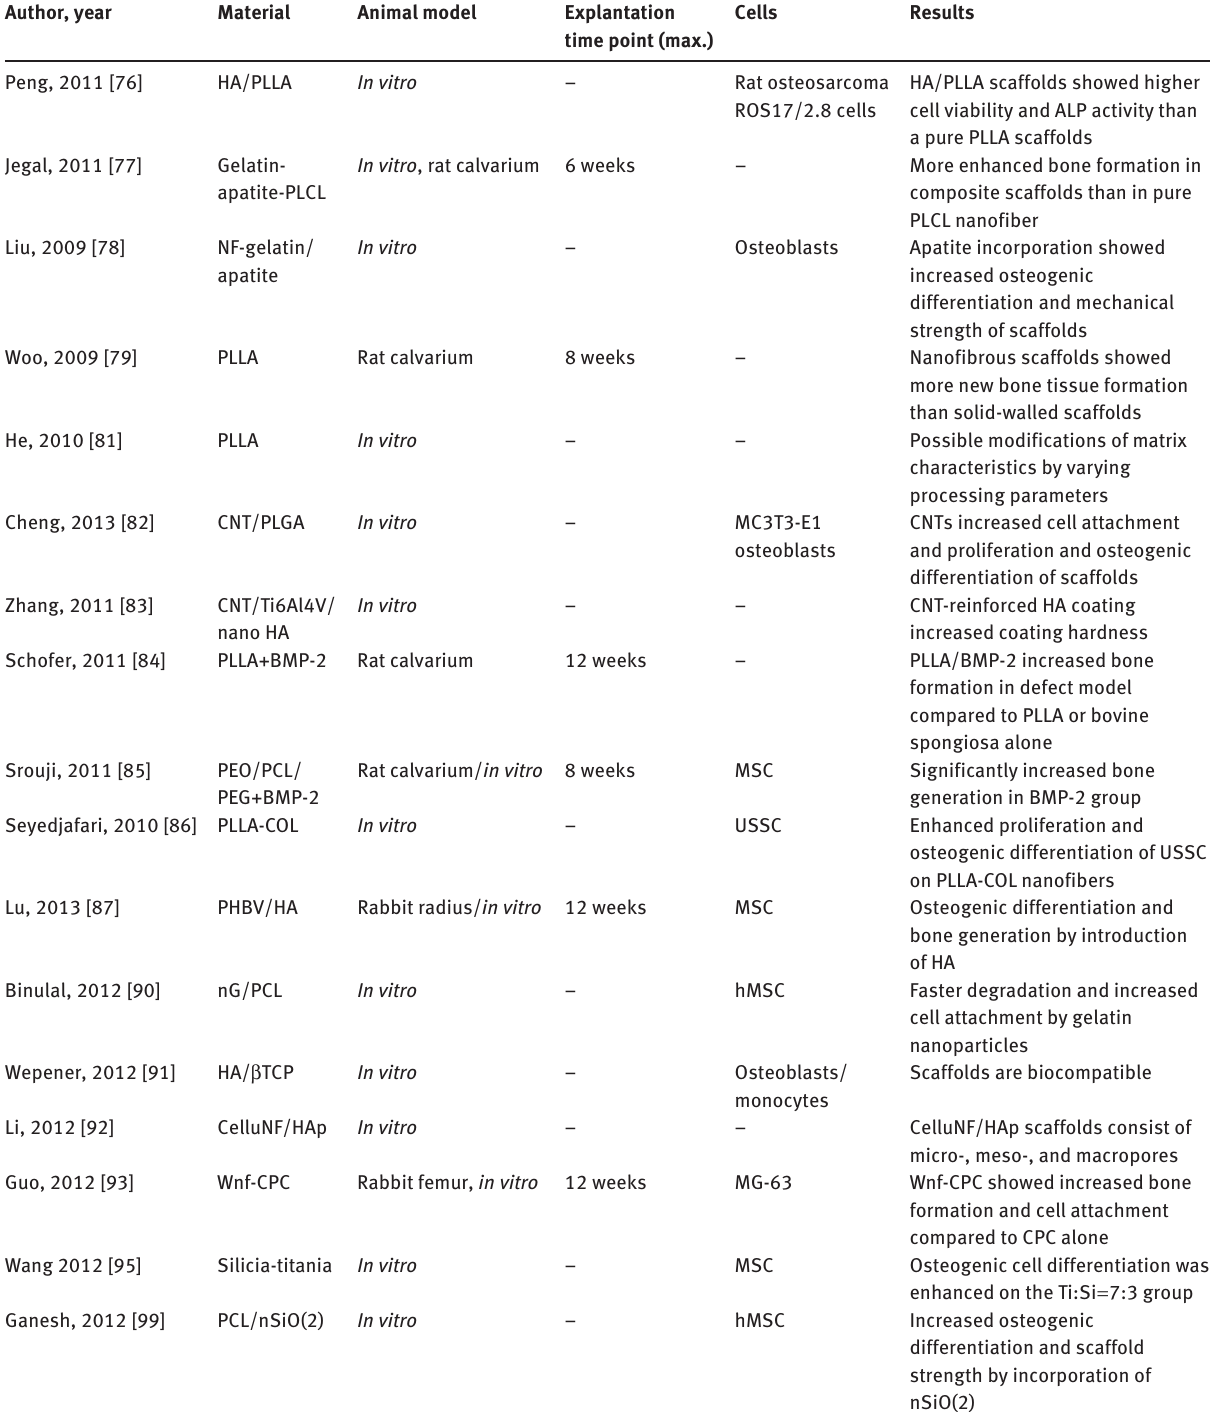
Table 3 Properties of different nanomaterials of bone tissue engineering. Author,